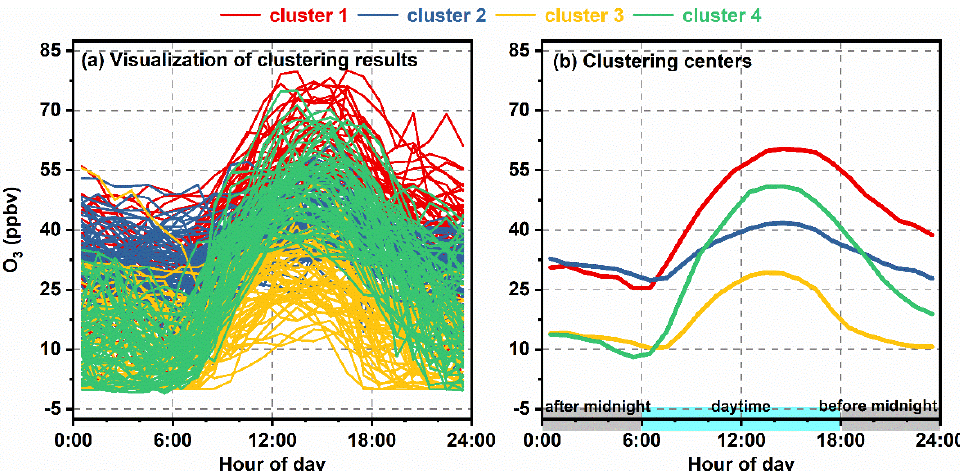
Figure 5. Visualization of the clustering results ( a ) and the final four clustering centers of the O 3 diurnal pattern ( b ).